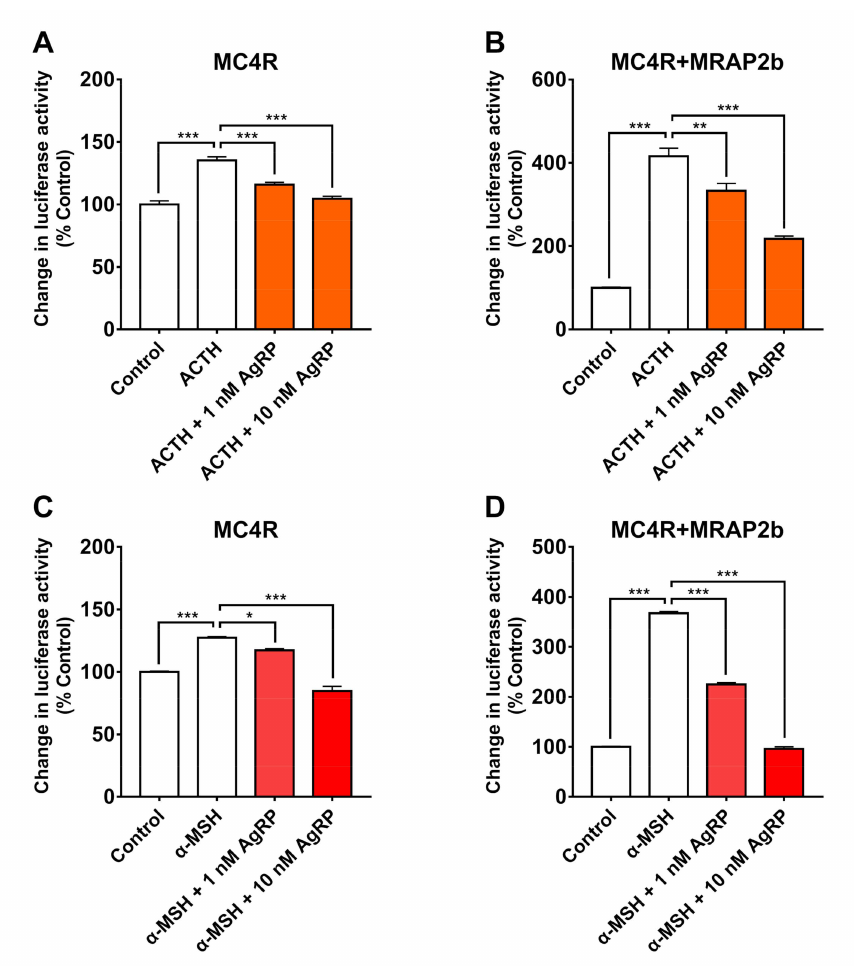
Figure 8. AgRP antagonizes the actions of tilapia ACTH / α -MSH on MC4R in the absence or presence of MRAP2b. ( A – D ) Human AgRP (1 nM and 10 nM, 6 h) could dose-dependently block the ACTH (10 nM)-stimulated ( A , B ) or α -MSH (10 nM)-stimulated ( C , D ) luciferase activity of CHO cells expressing MC4R in the absence ( A , C ) or presence ( B , D ) of MRAP2b, as monitored by a pGL3-CRE-luciferase reporter system. Each data point represents the mean ± SEM of 4 replicates ( n = 4). * p < 0.05; ** p < 0.01; ***, p <